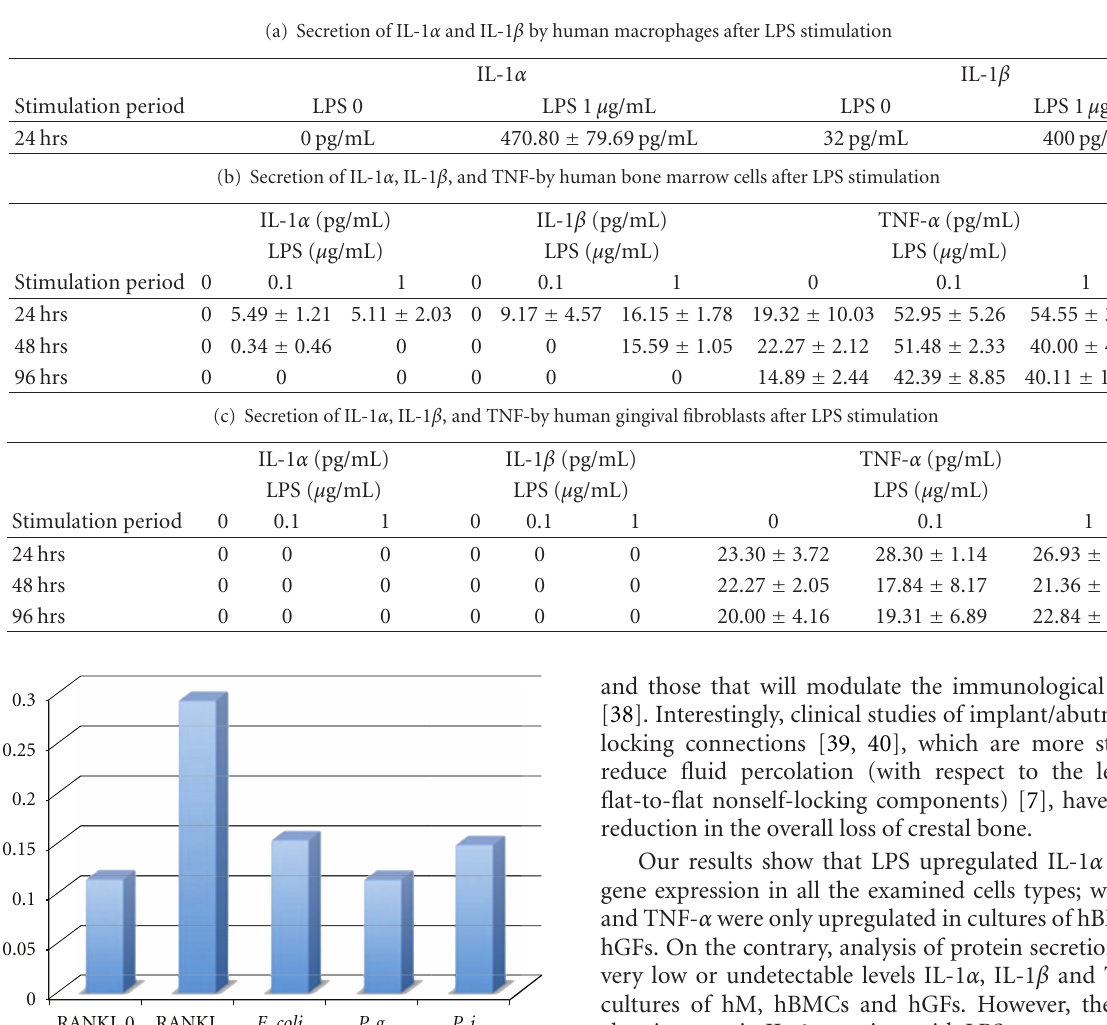
Table 3: ELISA results for hMO (a), hBMCs (b) and hGFs (c). For hMO, protein levels were assessed from the cell-free culture supernatants. hBMC and hGF protein levels were quantified from the cell lysate.